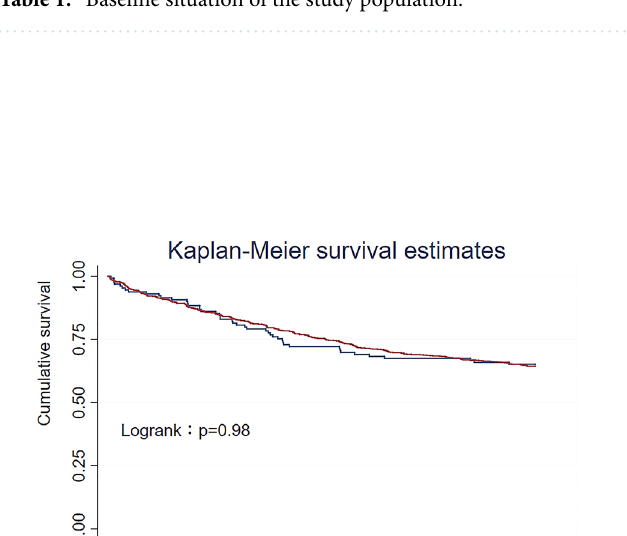
Table 1. Baseline situation of the study population.